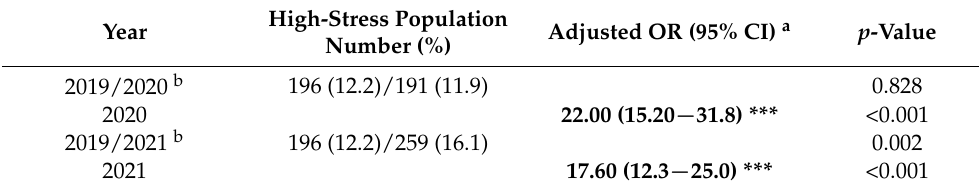
Table 3. Analysis of high-stress population proportion before and during the COVID-19